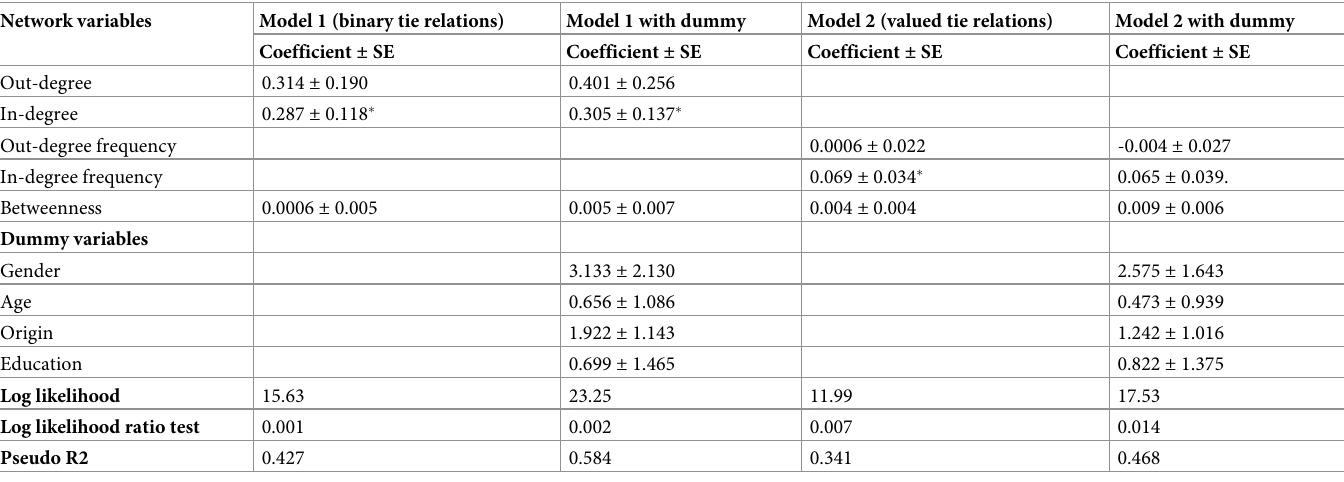
Table 4. Logistic regression estimates of ego farmer network measures of advice-seeking ties on the binary probability of farmers holding leadership